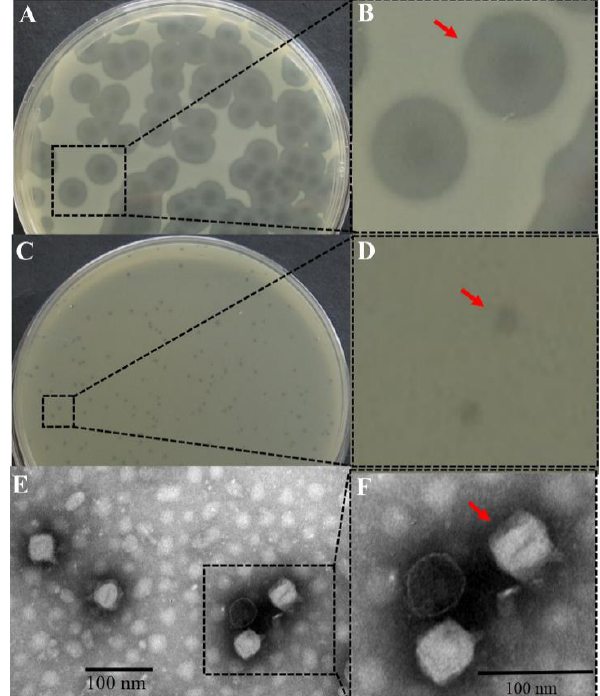
Figure 1. Morphology of phage. ( A ) Plaque morphologies of phage LPST153, the incubation time was 24 h, ( B ) Halo zone of phage LPST153, ( C ) Plaques morphologies of phage LPST89; the incubation time was 24 h, ( D ) No halo zone of phage LPST89 was observed, and ( E , F ) Representative TEM image of phage LPST153.